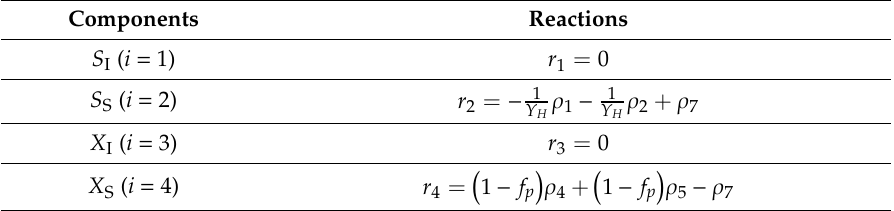
Table A6. Reaction rate equations of the 13